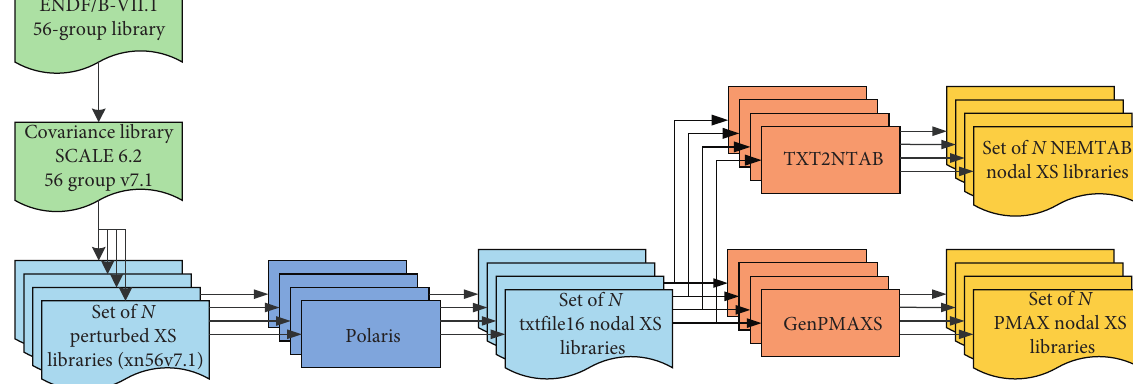
Figure 12: Process of generation of parameterized cross section libraries plus uncertainties.